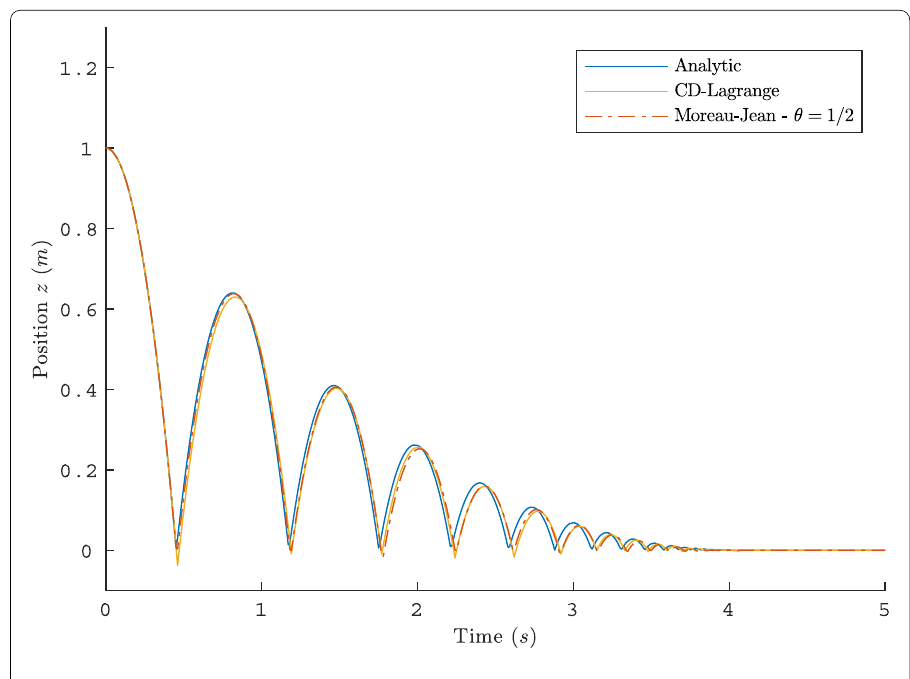
Fig. 6 Bouncing ball—position for Moreau–Jean and CD-Lagrange— e c = 0 . 8